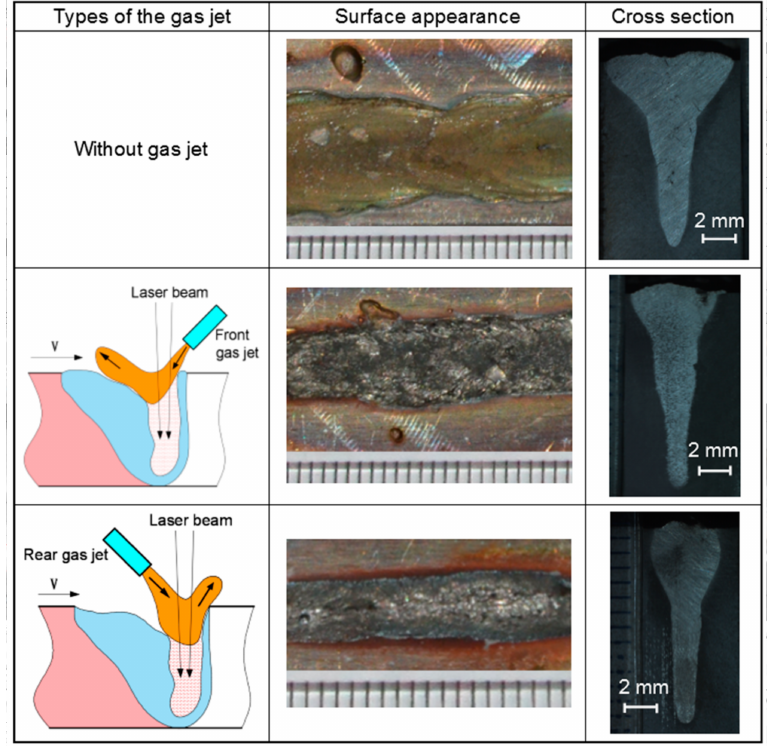
Figure 3. Effect of the gas jet on the weld appearance (p = 10 kW, v = 0.9 m/min, ∆ = − 5 mm, q = 10 L/min).